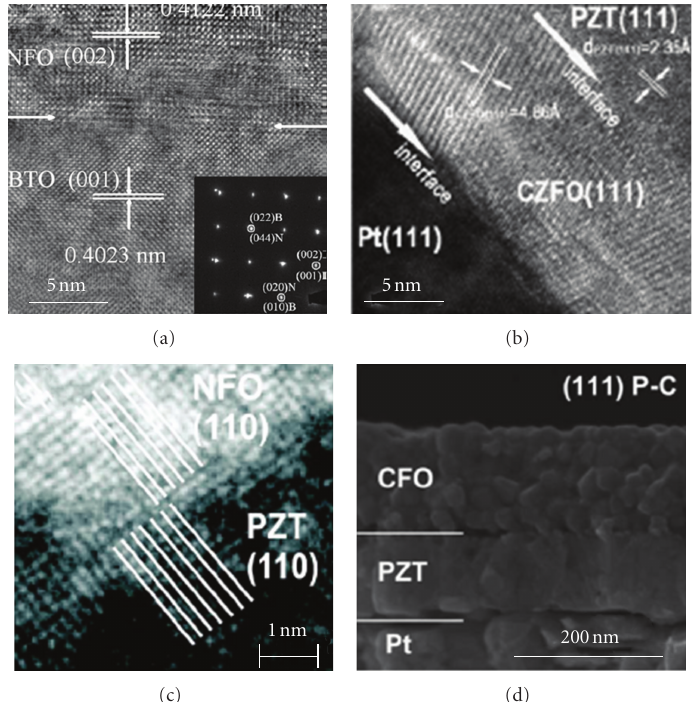
Figure 3: (a) HRTEM of BTO-NFO bilayer thin-film structure, (b) HRTEM of PZT-CZFO bilayer thin-film structure showing interface, (c) HRTEM of PZT-NFO nanoparticulate composite showing orientation relationship of NFO (110), and PZT (110), and (d) cross-sectional TEM image of PZT-CFO bilayer film